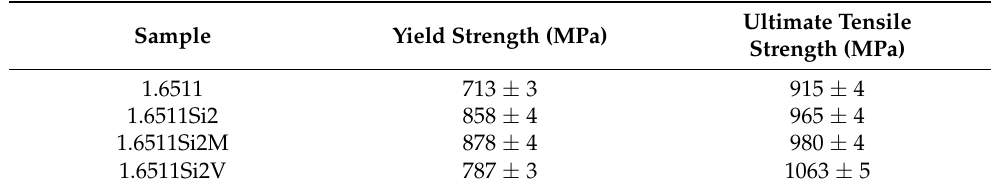
Table 2. Mechanical properties, including the yield stress (YS, with 0.2% offset) and ultimate tensile strength (UTS) of the